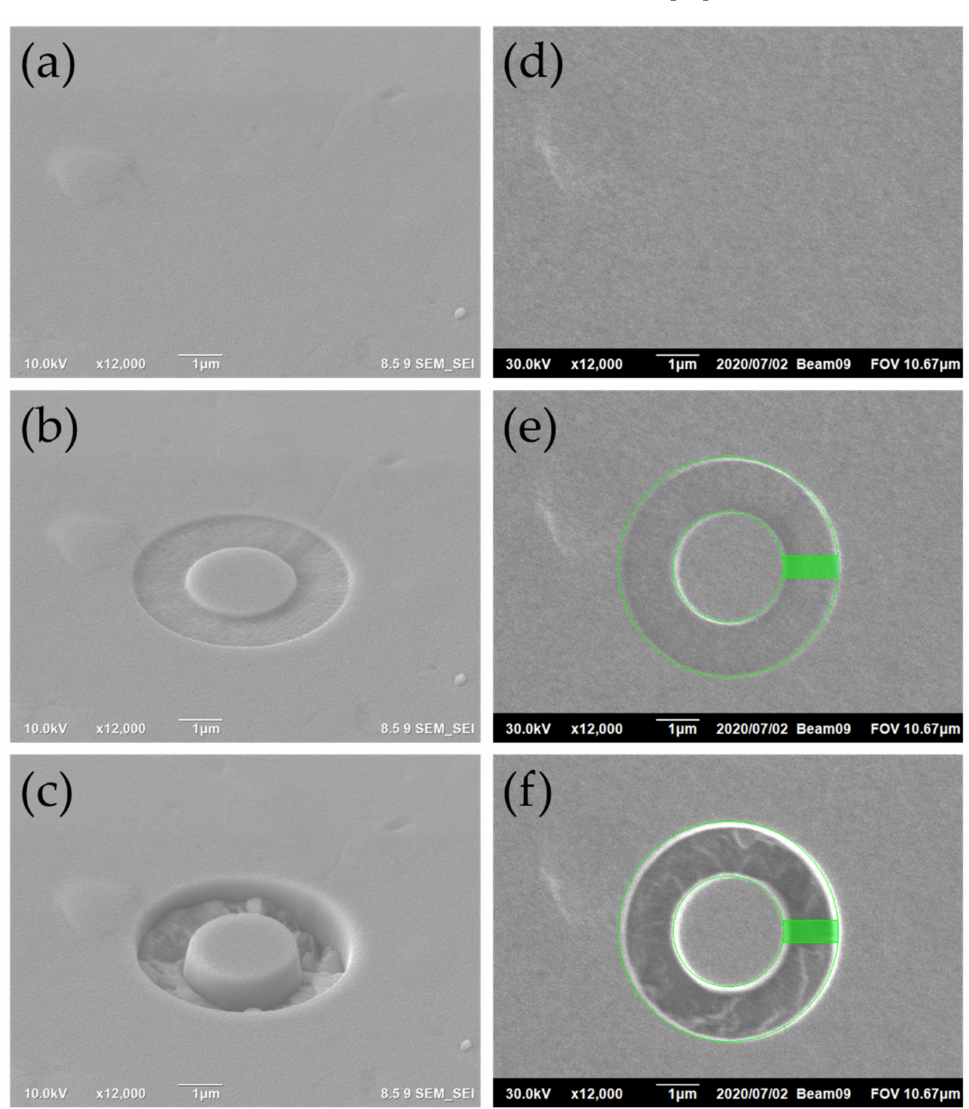
Figure 6. Images of TiN/Ti 8p sample: ( a ) Angular SEM image without milling, ( b ) Angular SEM image after 1st milling, ( c ) Angular SEM image after final milling, ( d ) Horizontal SEM image without milling, ( e ) Horizontal SEM image after 1st milling, and ( f ) Horizontal SEM image after final